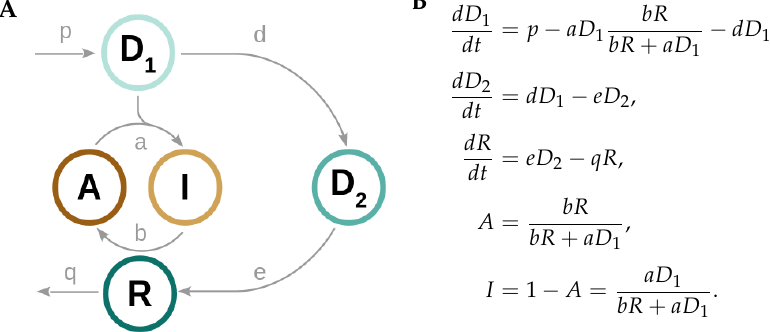
Figure 2. Core model for redox circadian oscillations. Scheme ( A ) and equations ( B ) of the core redox oscillator model. A represents active peroxiredoxin 3 (Prx3-SOH); I , inactive Prx3 (Prx3-SO 2 H); D 1 , mitochondrial H 2 O 2 ; D 2 , cytosolic H 2 O 2 ; and R , mitochondrial